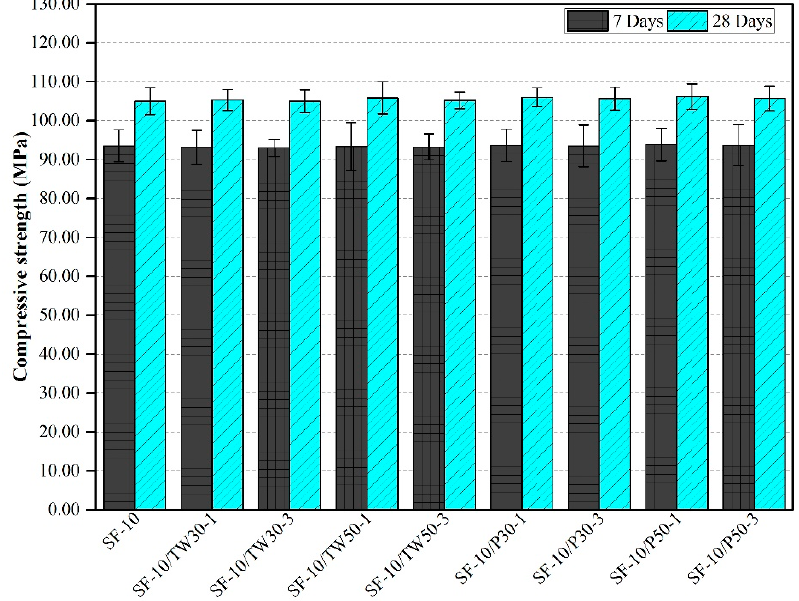
Figure 4. Compressive strength of mortars made with tea waste and perlite particles with SF.